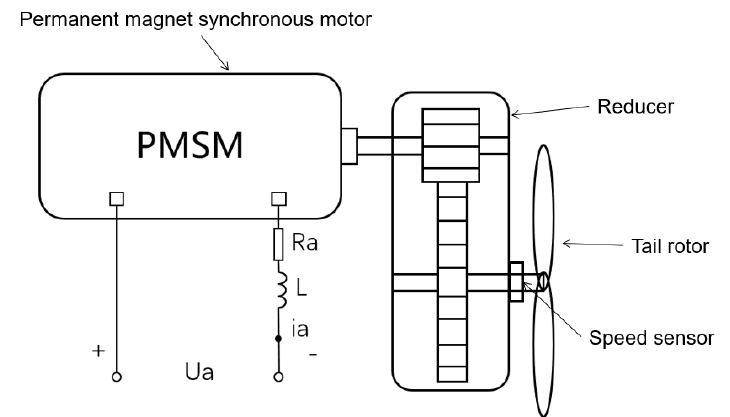
Figure 1. Electric tail reduction system.